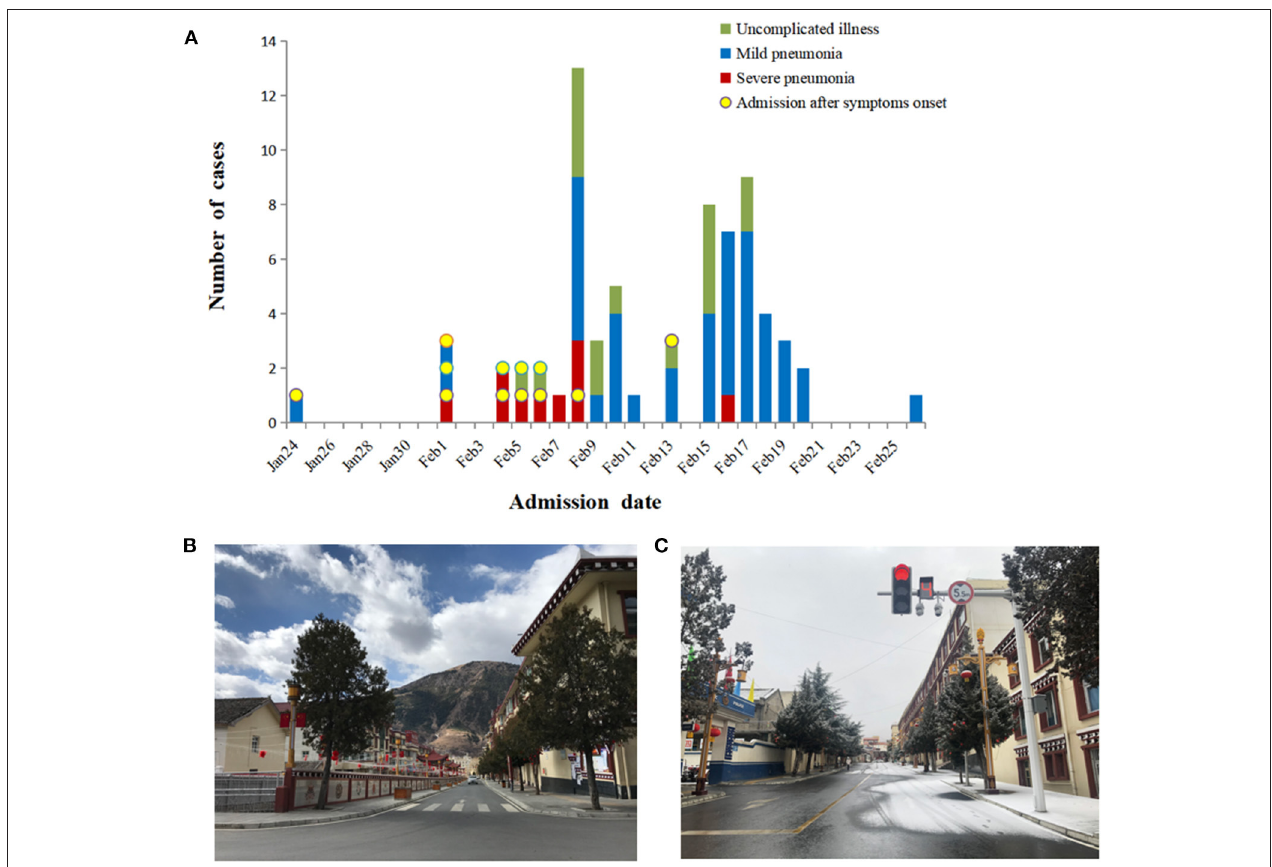
FIGURE 2 | Timeline of COVID-19 cases after onset of illness or active screening and disease control strategies. (A) Timeline of COVID-19 cases after onset of illness or active screening. (B,C) Disease control strategies led to empty streets and shopping centers.